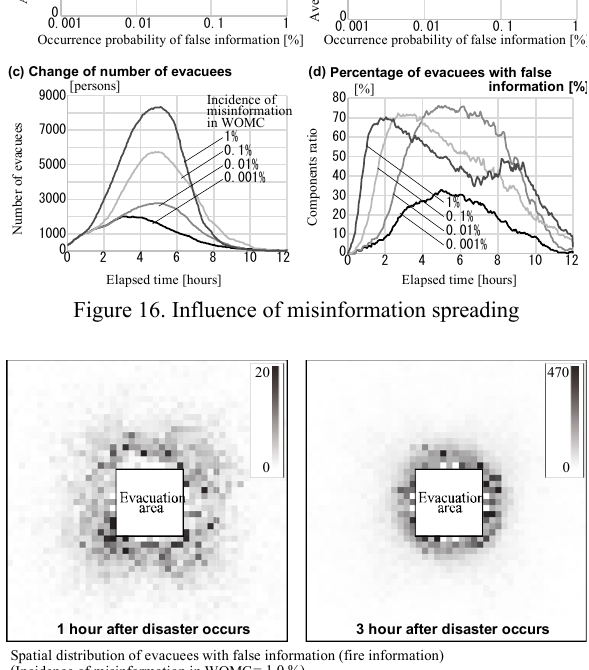
Spatial distribution of evacuees with false information (fire information) (Incidence of misinformation in WOMC = 1.0 Figure 17. Influence of false information spreading